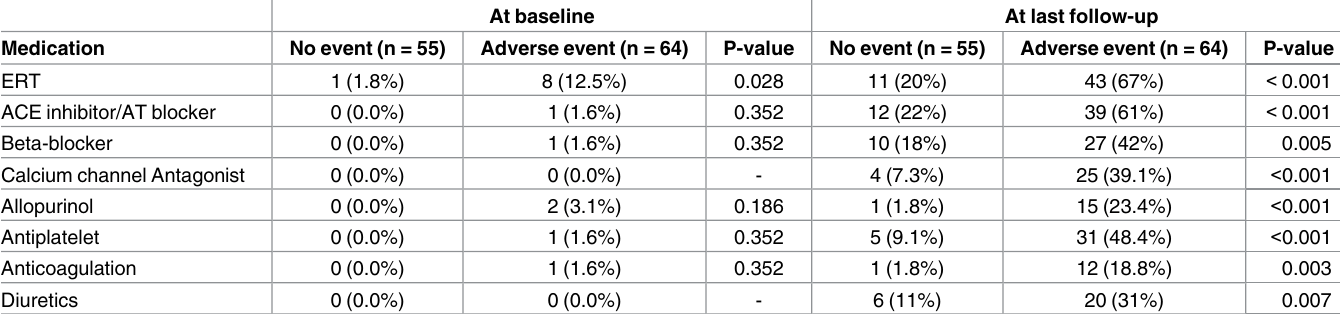
Table 2. Concomitant medication.